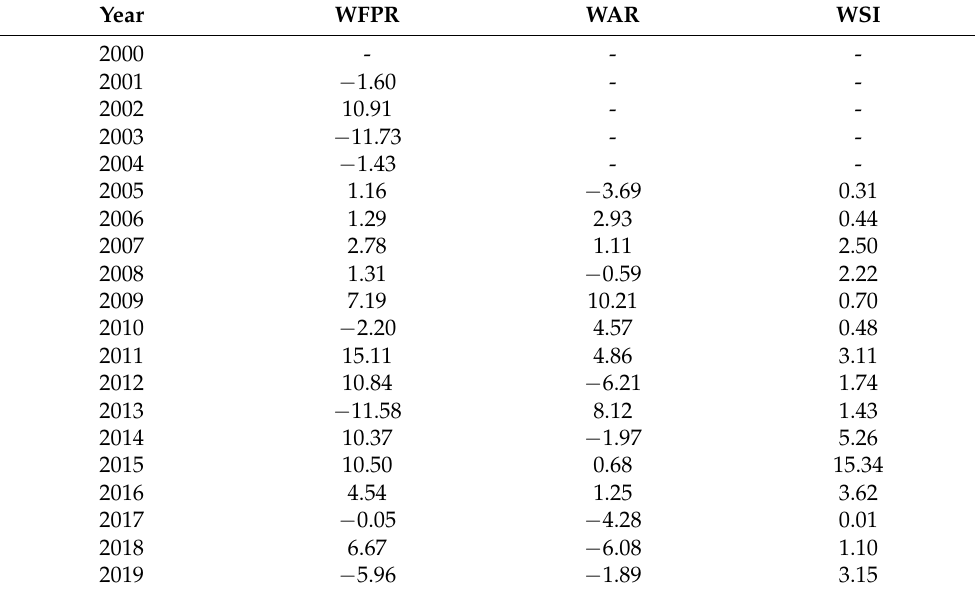
Table 6. Water sustainability performance indicators for 2000–2019 in Hotan.